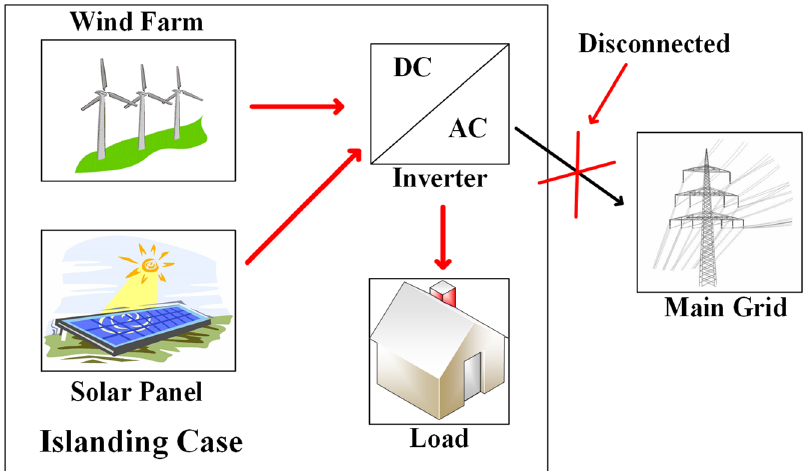
Figure 2. Islanding Scenario. Figure 2. Islanding